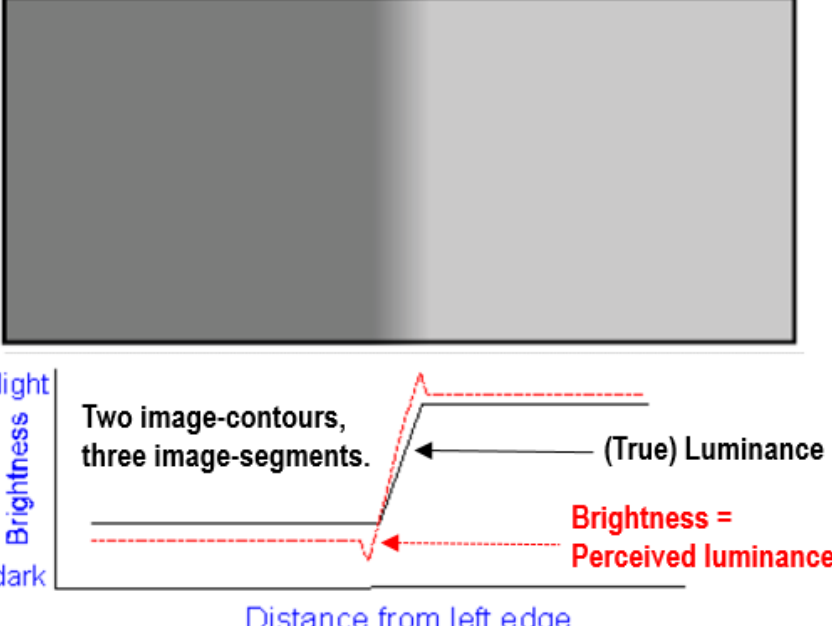
Figure 9. Mach bands illusion [13,156]. In black: Ramp in luminance units across space. In red: Brightness (perceived luminance) across space. One of the best-known brightness illusions, where brightness is defined as a subjective aspect of vision, i.e., brightness is the perceived luminance of a surface, is the psychophysical phenomenon of the Mach bands: where a luminance (radiance, intensity) ramp meets a plateau, there are spikes of brightness, although there is no discontinuity in the luminance profile. Hence, human vision detects two boundaries, one at the beginning and one at the end of the ramp in luminance. Since there is no discontinuity in luminance where brightness is spiking, the Mach bands effect is called a visual “illusion”. Along a ramp, no image -contour is perceived by human vision, irrespective o f the ramp’s local contrast (grad ient) in range (0, + ). In the words of Pessoa, “if we require that a brightness model should at least be able to predict Mach bands, the bright and dark bands which are seen at ramp edges, the number of published models is surprisingly small” [156]. In 2D signal (image) processing, the important lesson to be learned from the Mach bands illusion is that local variance, contrast and first-order derivative (gradient) are statistical features (data-derived numeric variables) computed locally in the (2D) image-domain not suitable to detect image- objects (segments, closed contours) required to be perceptually “uniform” (“homogeneous”) in agreement with human vision. In other words , these popular local statistics, namely, local variance, contrast and first-order derivative (gradient), are not suitable visual features if detected image- segments/image-contours are required to be consistent with human visual perception, including ramp-edge detection . This straightforward (obvious), but not trivial observation is at odd with a large portion of the existing computer vision (CV) and remote sensing (RS) literature, where many semi-automatic image segmentation/image-contour detection algorithms are based on thresholding the local variance, contrast or first-order gradient, e.g., [157 – 159], where a system’s free -parameter for thresholding image-objects or image-contours must be user-defined in range (0, + ) based on heuristics. Although it is largely ignored by large portions of the RS community, the unequivocal true fact that inherently ill-posed CV EO-IU algorithms for radiometric Cal of DNs into SURF or surface albedo values do require EO image classification to be performed in advance is implicitly confirmed